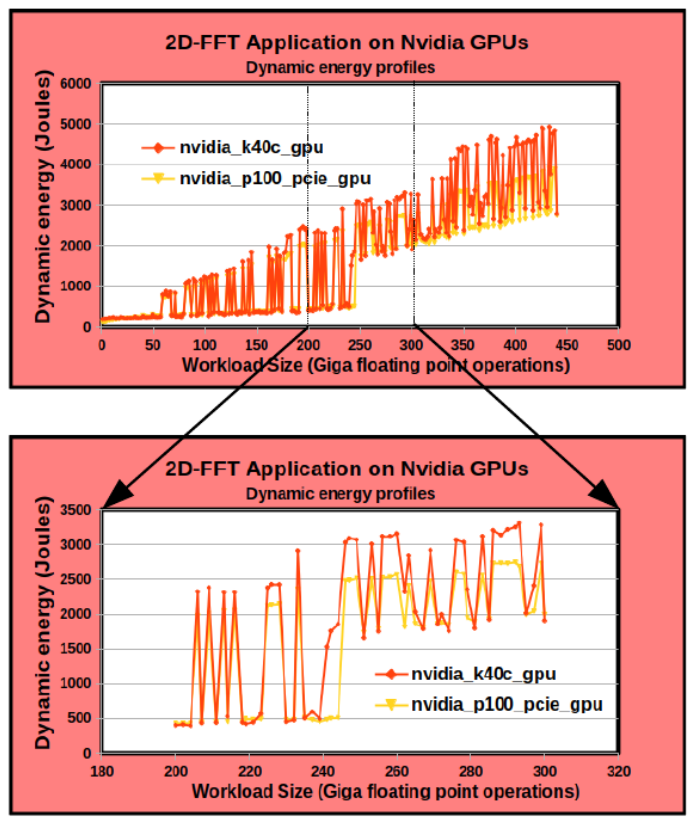
Figure 9. The dynamic energy consumption profile of the 2D-FFT application. The application computes a 2D discrete Fourier Transform of a dense complex signal matrix of size n × n on two GPUs, an Nvidia K40c GPU, and an Nvidia P100 PCIe GPU (Figure 1). The workload size is n and is shown in Giga floating point 5.0 × n 2 × log 2